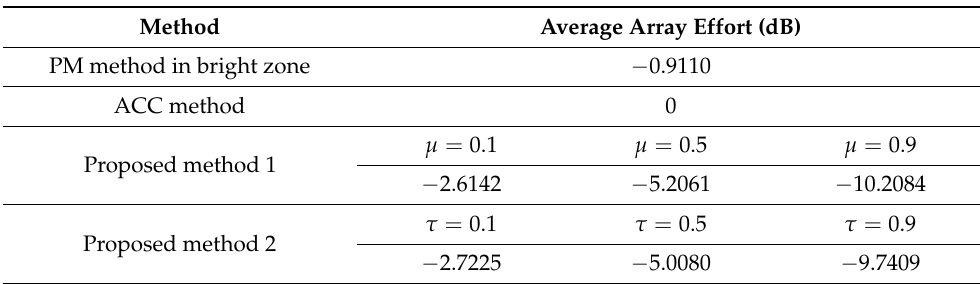
Table 11. Average array effort of different methods relative to frequency for two-dimensional experiment with sparse sampling points.